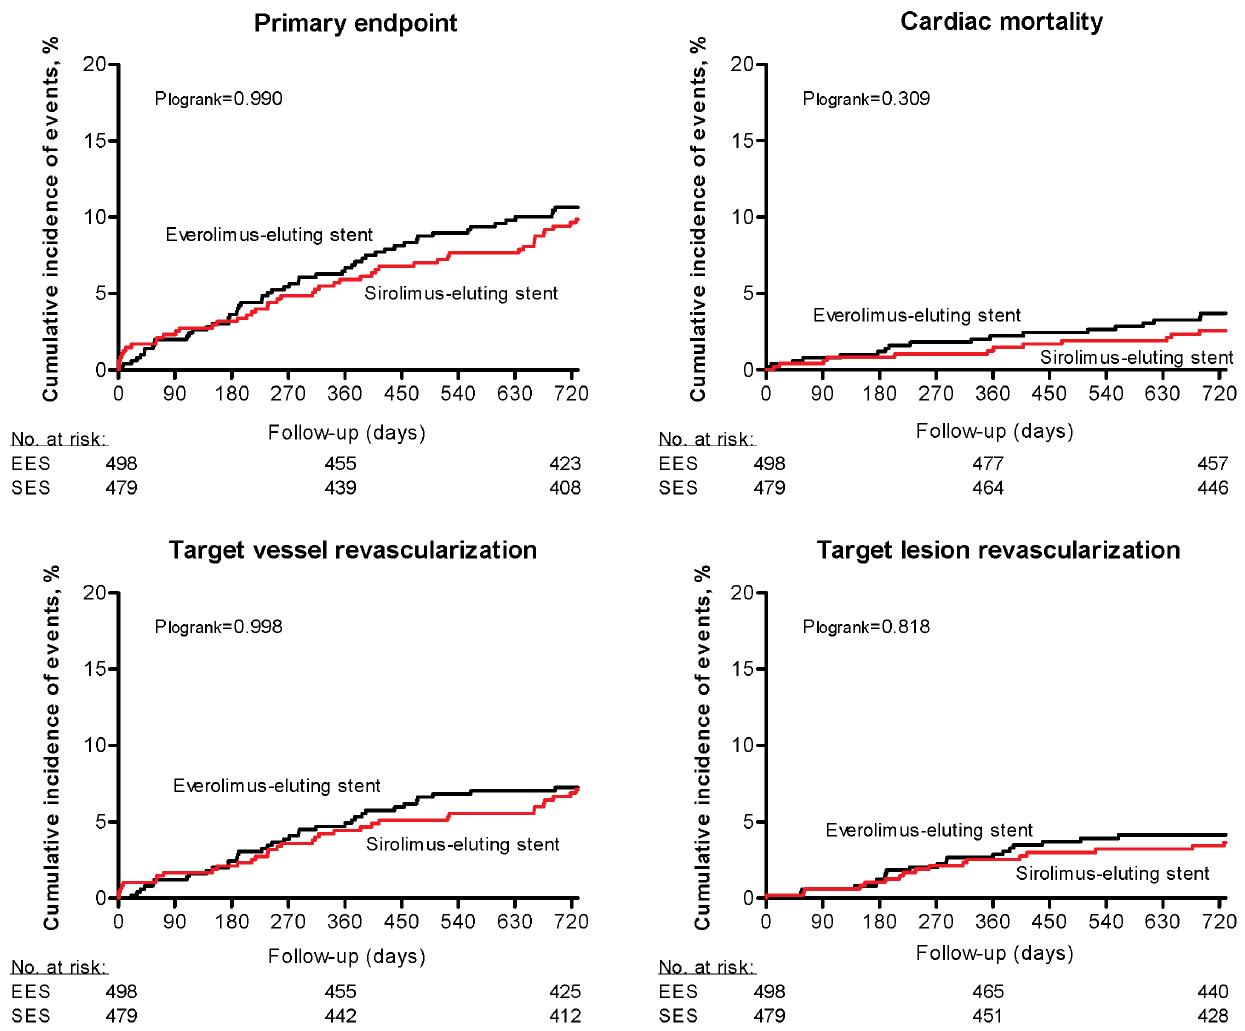
Figure 2. Two-year clinical outcomes. Primary endpoint=composite of cardiac mortality, myocardial infarction and target vessel revascularization.